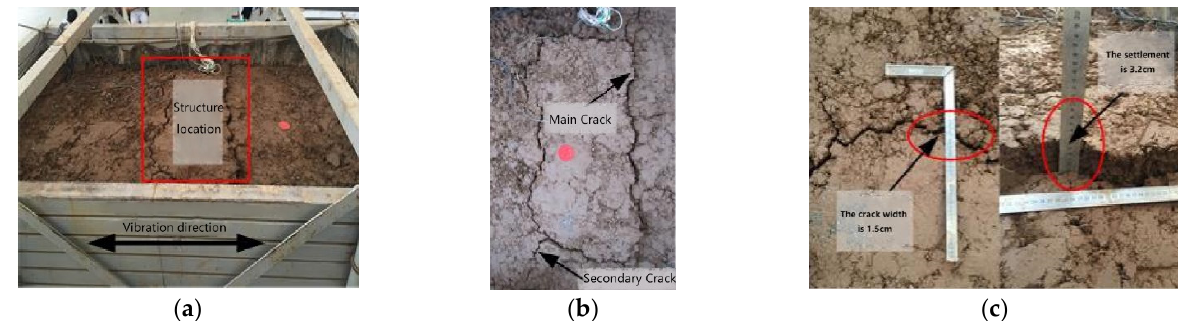
Figure 12. Final seismic failure phenomenon of the foundation in the model test: ( a ) macroscopic earthquake damage, ( b ) fracture distribution, ( c ) crack and settlement measurement.